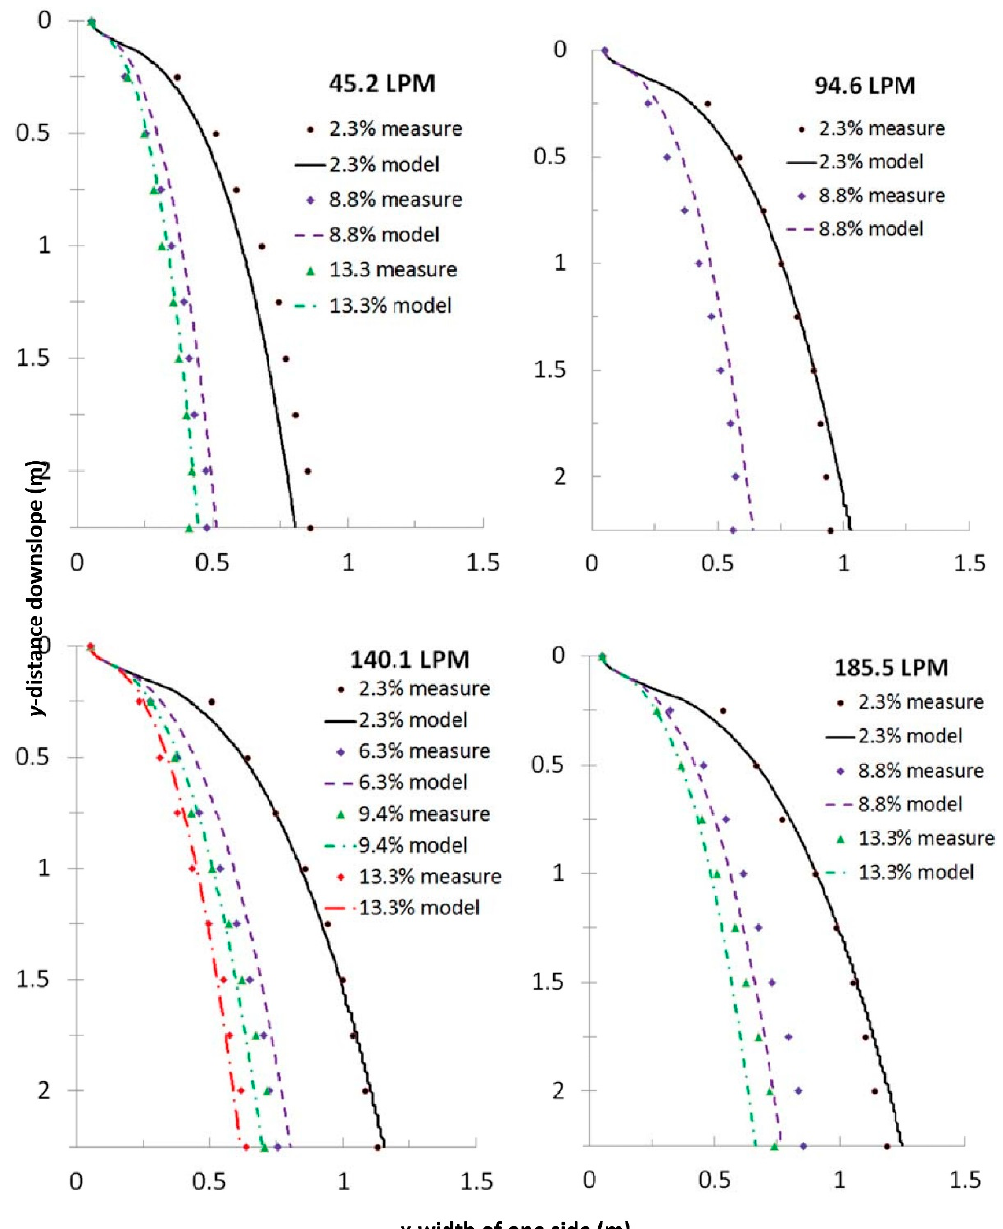
Figure 4. Measured and modeled results of one side of the water spreading onto a roughened painted surface for varying Q and S y with x 0 = 10.2 cm and n varying with slope as per Equation (14). The measured x values are the average of the right and left sides at that value of y .